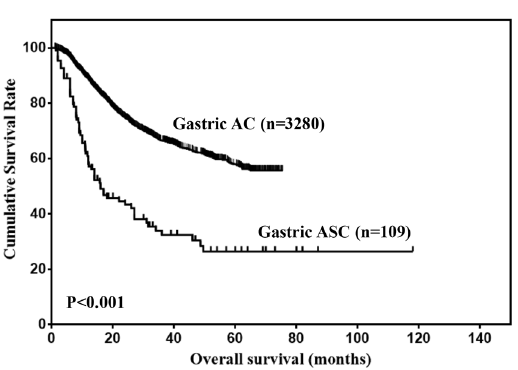
Figure 2. Comparison of OS between gastric ASC and AC for the entire